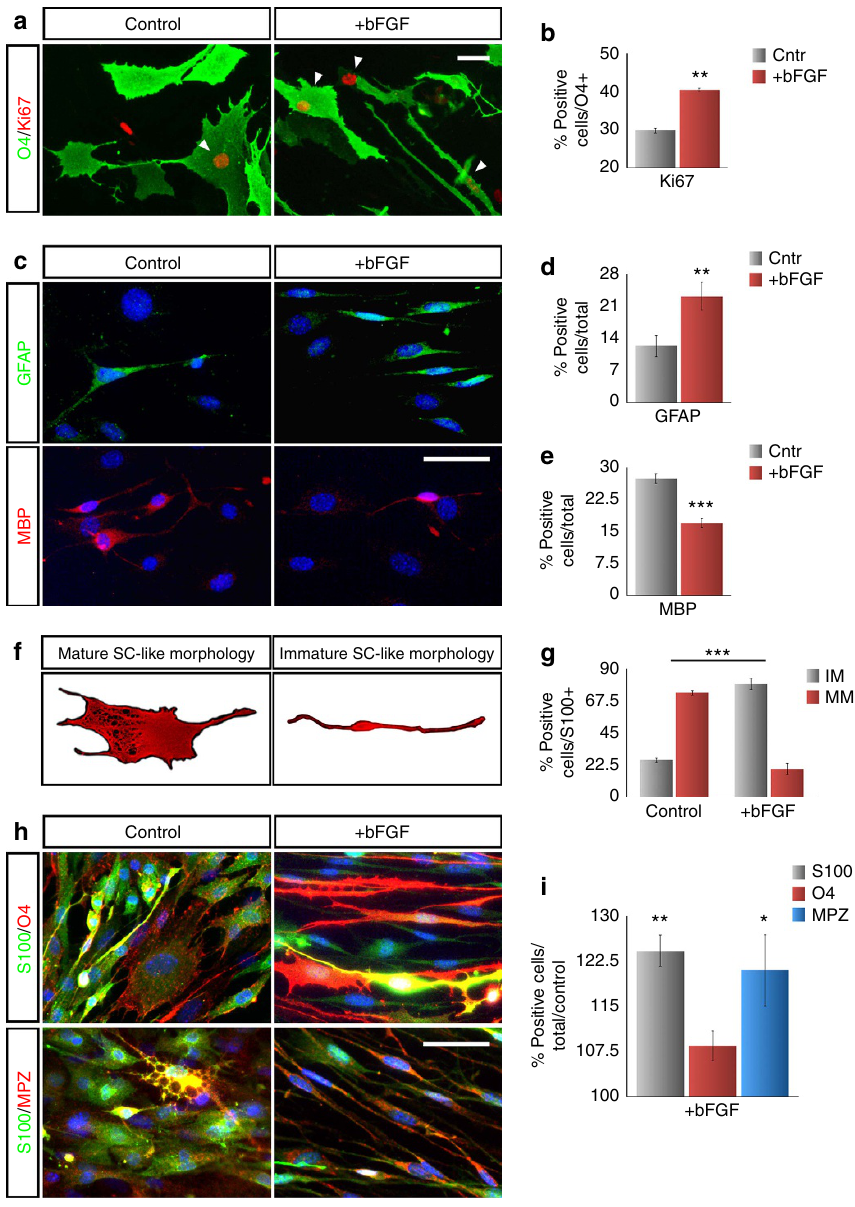
Figure 3 | bFGF maintains iSCs in an immature and highly proliferative state. Immunofluorescence ( a ) and quantification ( b ) for Ki67 staining in O4 þ iSCs with or without bFGF stimulation 1 week after dox withdrawal (Mean ± s.d., n ¼ 5 independent experiments, three coverslips for each,